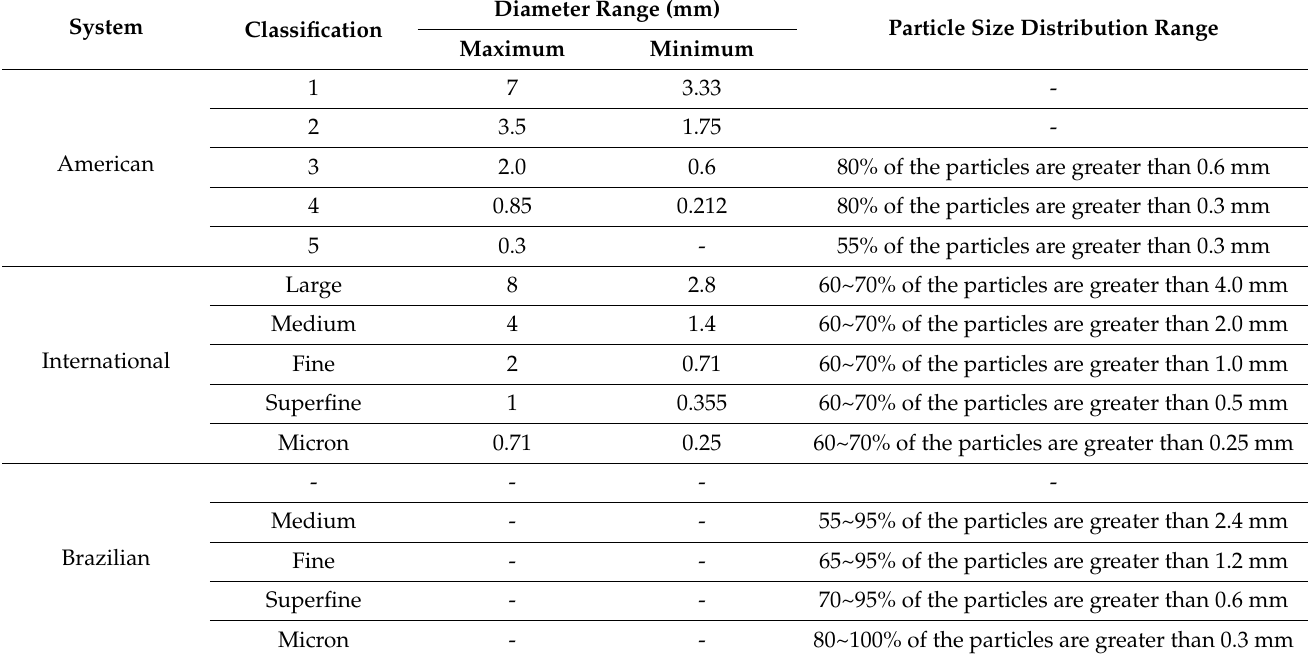
Table 2. Particle size classification of vermiculite